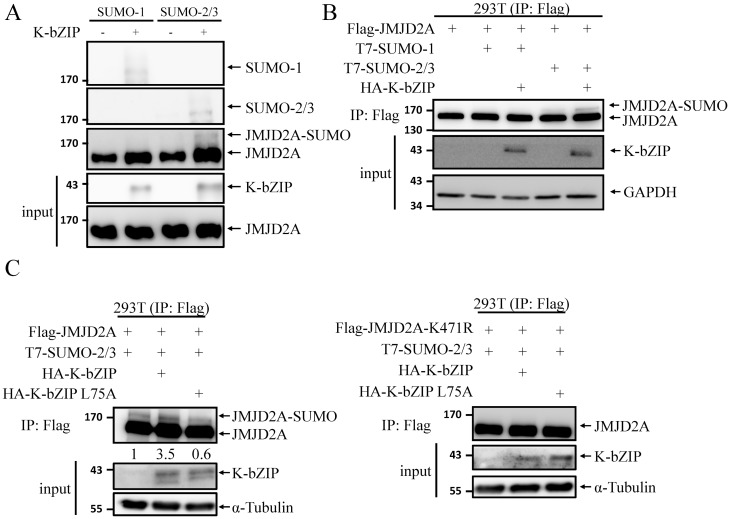
KSHV SUMO E3 ligase K-bZIP catalyses SUMO modification of JMJD2A.(A) in vitro SUMOylation assay of JMJD2A was performed with the indicated combination of SUMO isoforms and K-bZIP. JMJD2A and SUMOylated JMJD2A were resolved by 4%-20% gradient SDS-PAGE and immunoblotted using anti-SUMO-1, anti-SUMO-2/3 and anti-JMJD2A antibodies. Input of JMJD2A and K-bZIP was detected by immunoblotting using specific antibodies as indicated. (B) in vivo SUMOylation assay was performed as described in Fig 2C, with co-transfection of Flag-JMJD2A (0.4 μg), T7-SUMO-1 or T7-SUMO-2 and -3 (0.1 μg), and WT K-bZIP (0.1 μg). 4%-20% gradient SDS-PAGE was used to resolve JMJD2A and SUMOylated JMJD2A. Immunoblotting was performed using anti-JMJD2A, anti-K-bZIP and anti-GAPDH antibodies. (C) Flag-K-bZIP-WT or -L75A were co-expressed in 293T cells with Flag-JMJD2A and T7-SUMO-2 and -3 as described in (B). SUMOylated JMJD2A and input proteins were detected by immunoblotting using specific antibodies as indicated. Ratio is the relative signal of JMJD2A-SUMO to total JMJD2A observed using signal in lane 1 set as 1.0.